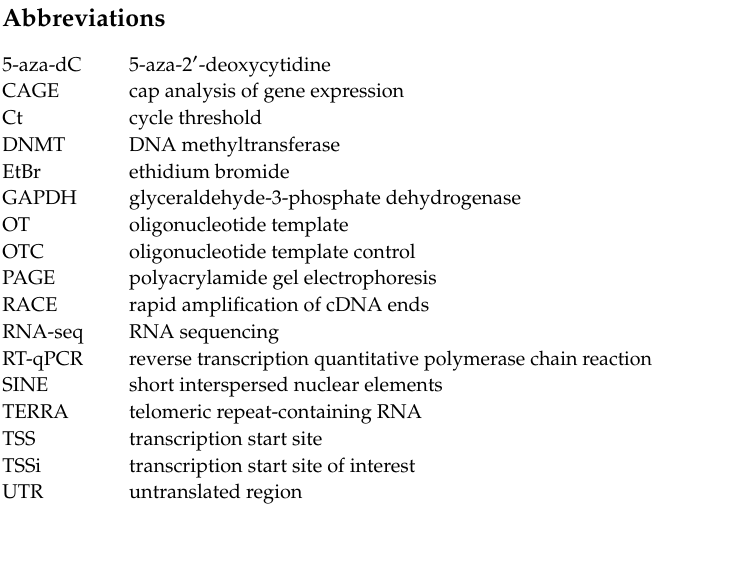
Figure S1: Schematic illustration showing the in vitro transcription of the synthetic TERRA, Figure S2: Digestion of the template oligonucleotide OT by